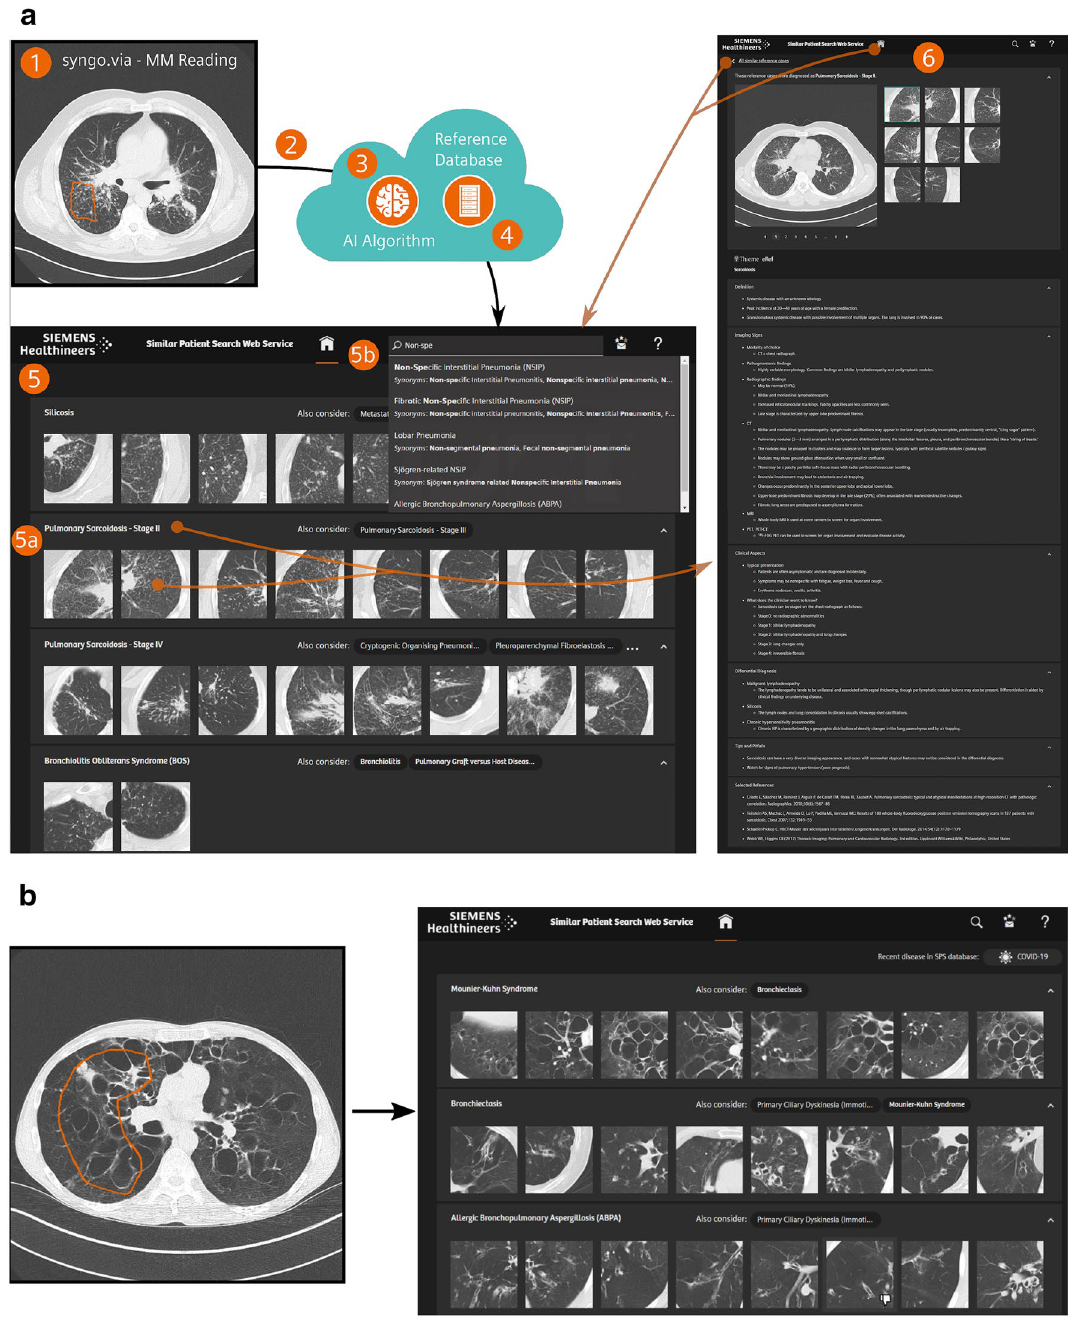
Figure 2. ( a ) Schematic Illustration of the Similar Patient Search Web Service. ( 1 ) The user selects an ROI on an axial CT slice using the host Application ( syngo .via VA40A). The slice, along with the ROI, is sent to the cloud service ( 2 ). A deep-learning-based feature representation (fingerprint) for the slice/ROI combination is computed in the cloud ( 3 ). The fingerprint is then compared to pre-generated fingerprints from the reference database ( 4 ). The tool returns a webpage that shows the most similar image patches from the reference database and their corresponding diagnosis ( 5 ). The clinical reference content from Thieme is accessible by a single click on the disease detail page ( 6 ). ( b ) Example SPS result from the study: Left: Input Slice (case with Mounier Kuhn Syndrome) with the ROI chosen by the study participant (orange outline) Right: SPS User interface with top 3 results of the similarity search for this